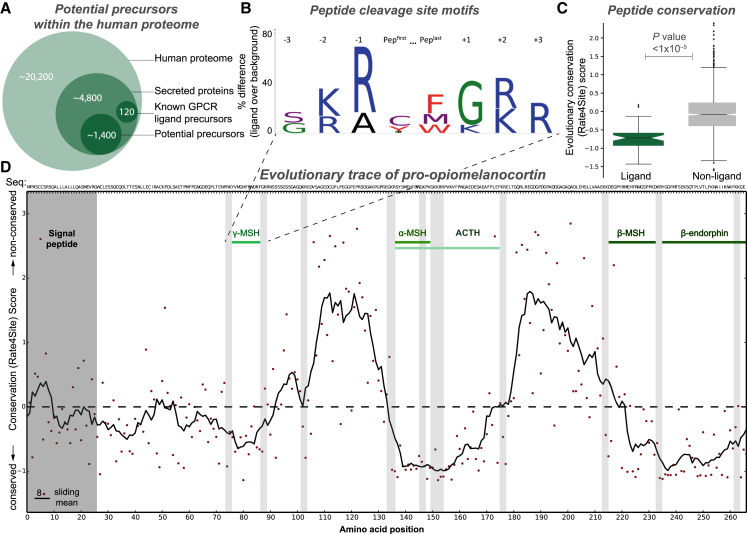
Universal Precursor Processing and Peptide Ligand Gene Conservation Hotspots(A) Potential precursors can be mined from the human proteome based on the presence of secretion signal peptides and an unknown or ligand-precursor-like function (Table S4).(B) The vast majority of GPCR peptide ligands are cleaved from precursors at specific dibasic sites.(C) GPCR peptide ligands are more evolutionarily conserved than random sequences of similar length (up to 45 residues) (Wilcoxon rank-sum test, p < 1 × 10−5).(D) Human peptide ligands can be deduced from precursor cleavage sites and conservation hotspots. The example depicts the pro-opiomelanocortin precursor containing endogenous ligands for melanocortin (α-MSH, β-MSH, γ-MSH, and ACTH) and opioid (β-endorphin) receptors.